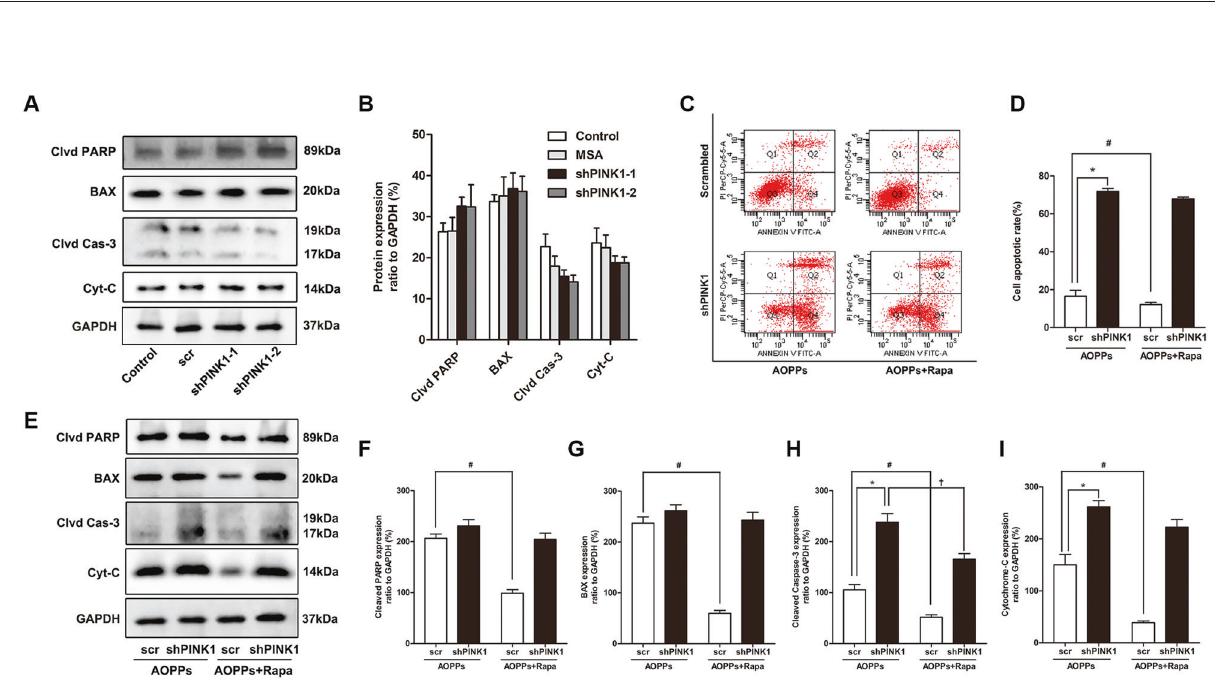
Fig. 4 PINK1 knockdown aggravated AOPP-induced osteoblast apoptosis. A , B PINK1 knockdown by shRNA had no signi fi cant effect on the expression of cleaved PARP, BAX, cleaved Caspase-3, or cytochrome c in MC3T3-E1 cells. C , D Flow cytometry results showed that